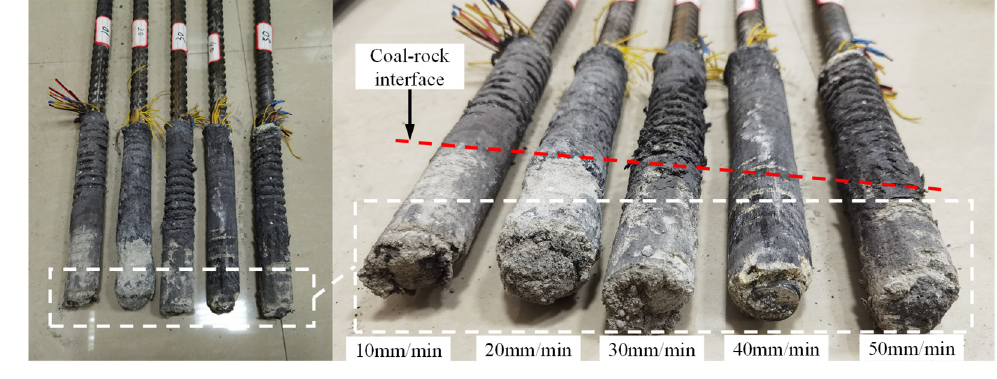
Figure 9. Bolt specimens after